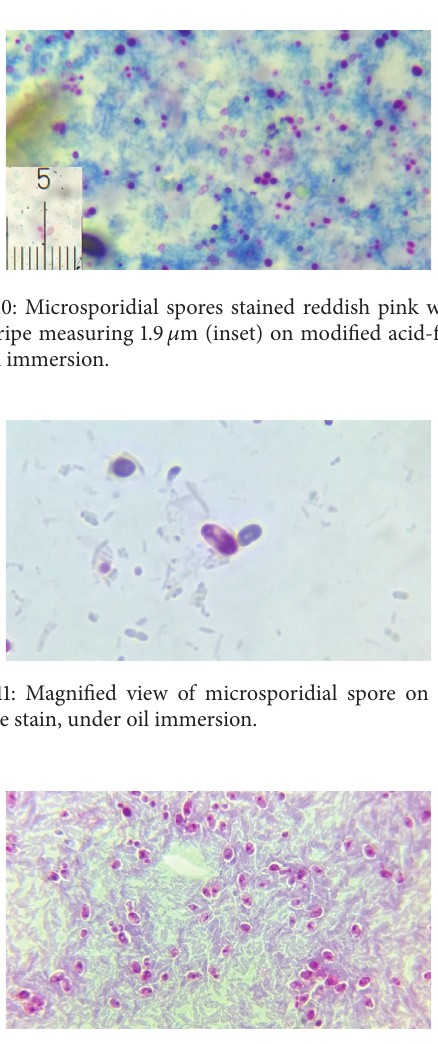
Figure12:Cystsof Chilomastixmesnili onmodifiedtrichromestain, under oil immersion.